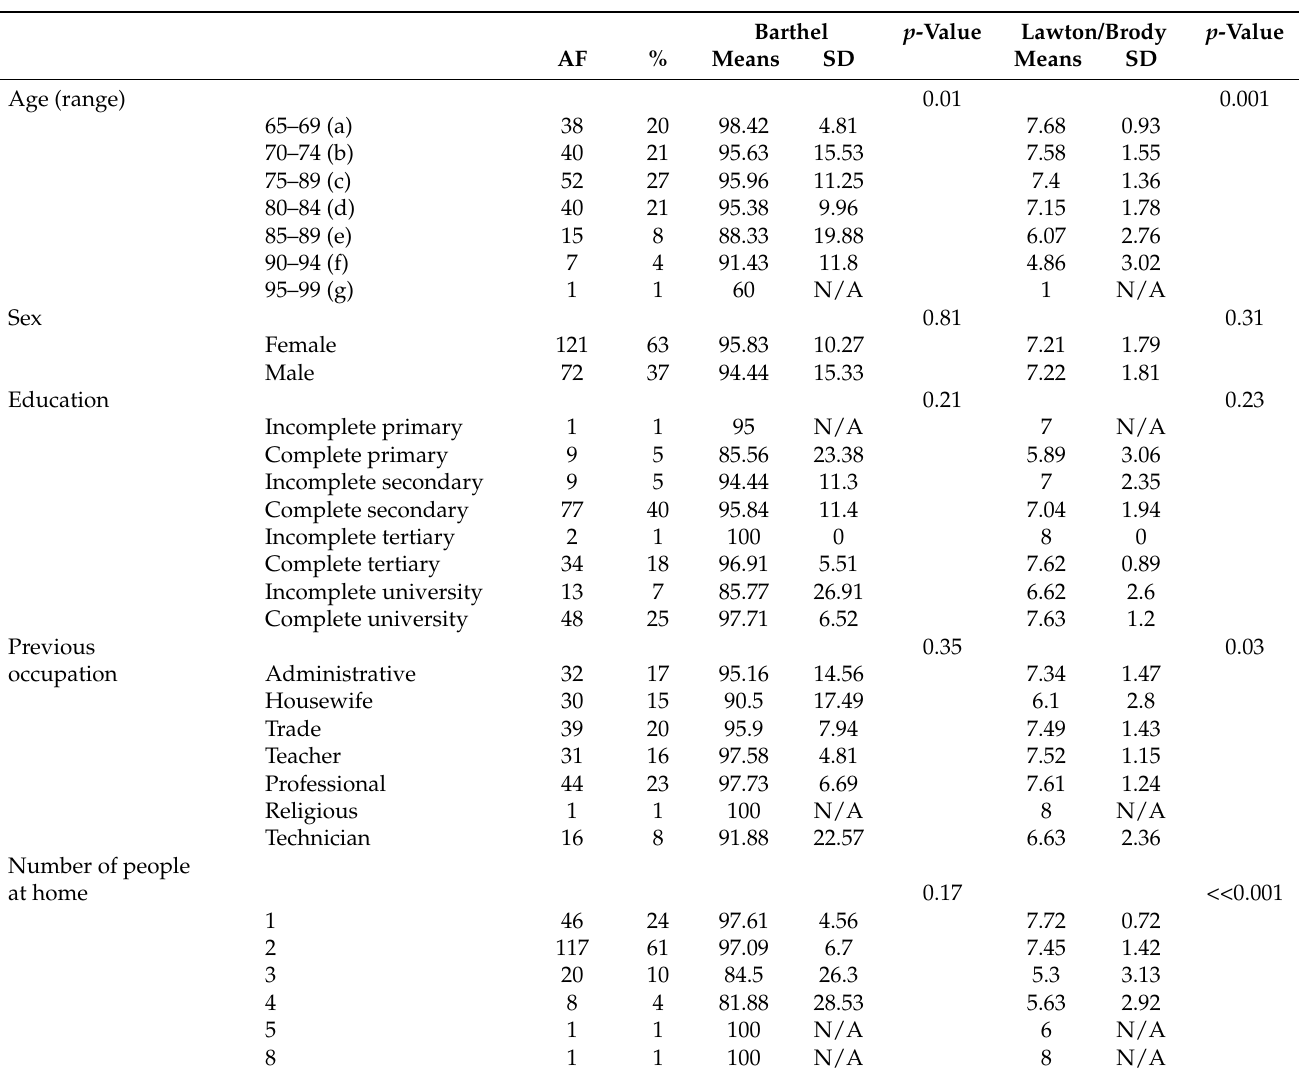
Table 1. Relationship between sociodemographic variables, the Barthel index, and the Lawton and Brody scale.